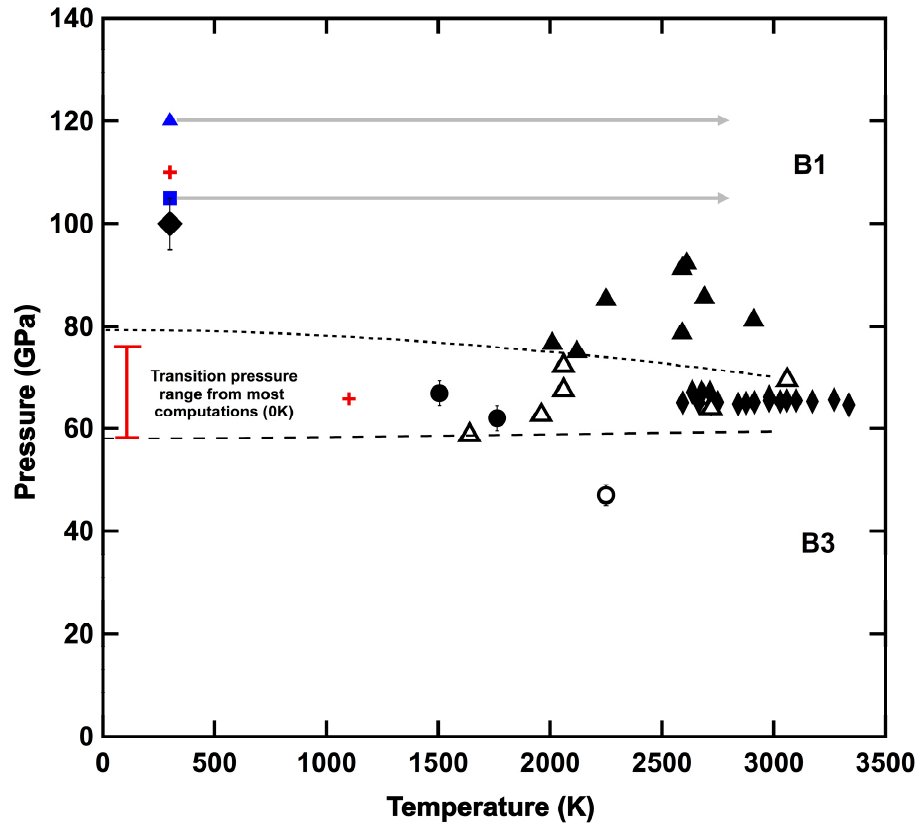
Figure 3. Experimental data from DAC (black), shock, (blue), and selected computational results (red) for the high-P-T transition conditions to the rocksalt (B1) structure. All data shown start with the cubic B3 polytype aside from the shock study [21], which starts with the 6H polytype. Bars extending from shock studies (blue triangle [20], blue square [21]) indicate the likely high sample temperature. Open symbols represent the low pressure B3 structure (open circle [24], open triangles [27]) while solid symbols indicate the appearance or stability of the B1 structure in (LH) DAC experiments (solid circles [24], solid triangles [27], solid thick diamond [25], solid thin diamonds [28]). Computations considering the hysteresis across the transition are plotted in red crosses [44], while the range of most transition temperatures found in computational studies is shown by the red bar. Long dashed line indicates Clapeyron slope proposed by [24] while short dashed line indicates Clapeyron slope proposed by